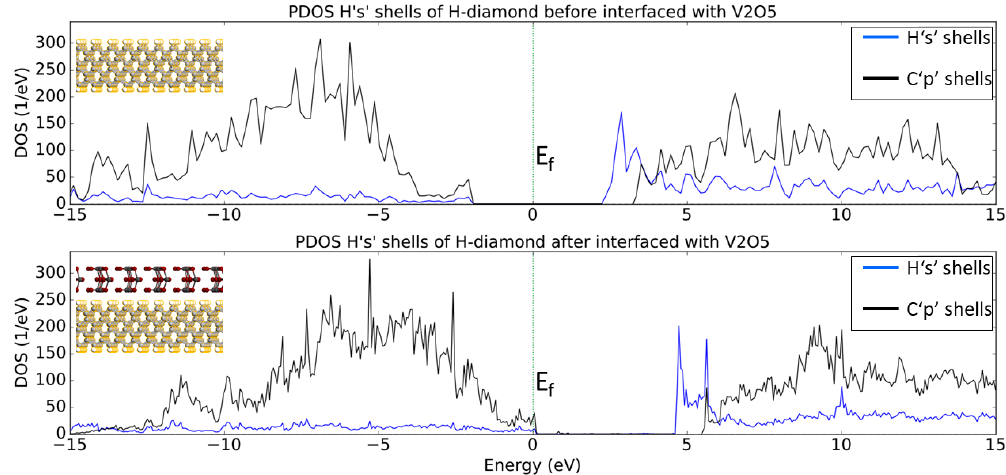
Figure 9. PDOS plots of Hs and Cs shells before and after the H-diamond is interfaced with V 2 O 5 .The images inset are 2D cuts in the middle of the systems just to show what atoms are being projected in the PDOS plots. in the PDOS plots.